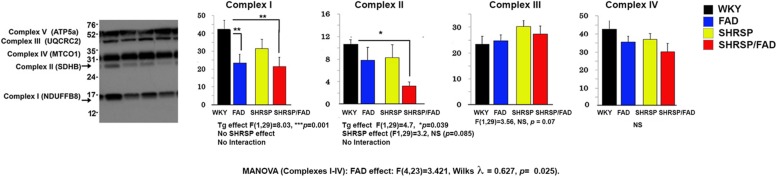
Mitochondrial complex II is reduced in the hippocampus of SHRSP/FAD rats and mitochondrial complex I is reduced in FAD rats. We measured mitochondrial complexes I-IV from hippocampal tissue by western blot and MANOVA was performed on the relative optical densities of protein bands from complexes I (log transformation), and II-IV. Results showed no sex effects, but a significant main FAD effect (p = 0.025) and the univariate test showed significant FAD main effects for Complexes I and II (p < 0.0001 and p < 0.039, respectively), but not III and IV. Although complex I proteins were significantly reduced in SHRSP/FAD (p < 0.01) and FAD (p < 0.01) rats, compared to WKY, complex II levels, were significantly reduced more than threefold in SHRSP/FAD rats, compared to WKY (p < 0.05). Data represent means ± SEM. ∗p < 0.05, ∗∗p < 0.01; MANOVA with Wilks λ test and LSD Fisher’s post hoc test.